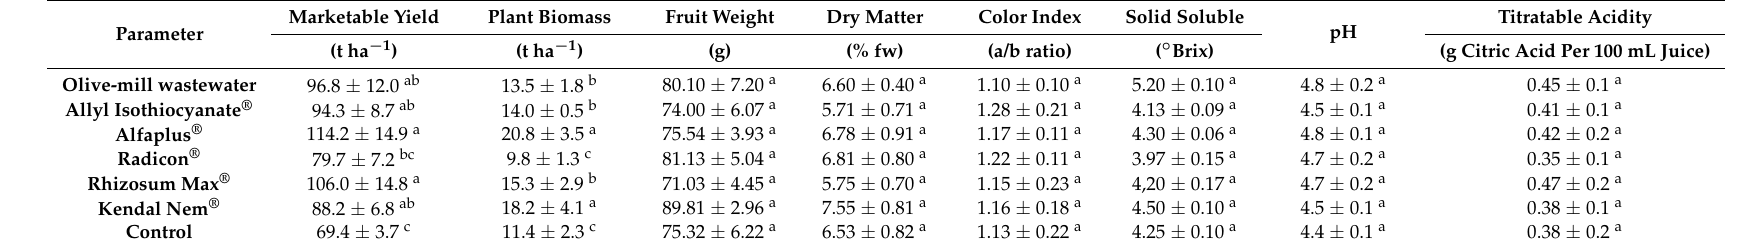
Table 2. Effects of quanti-qualitative traits of the tomato fruits under different treatments (second